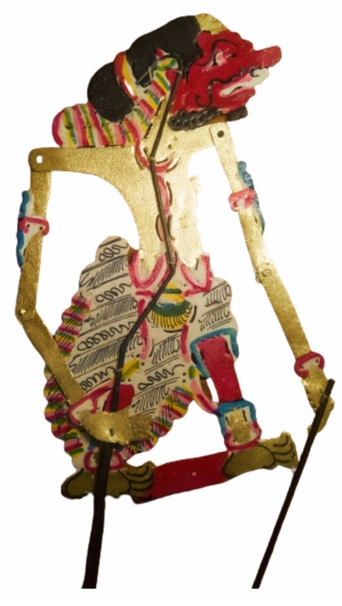
Figure 4. Sengkuni or Shakuni.